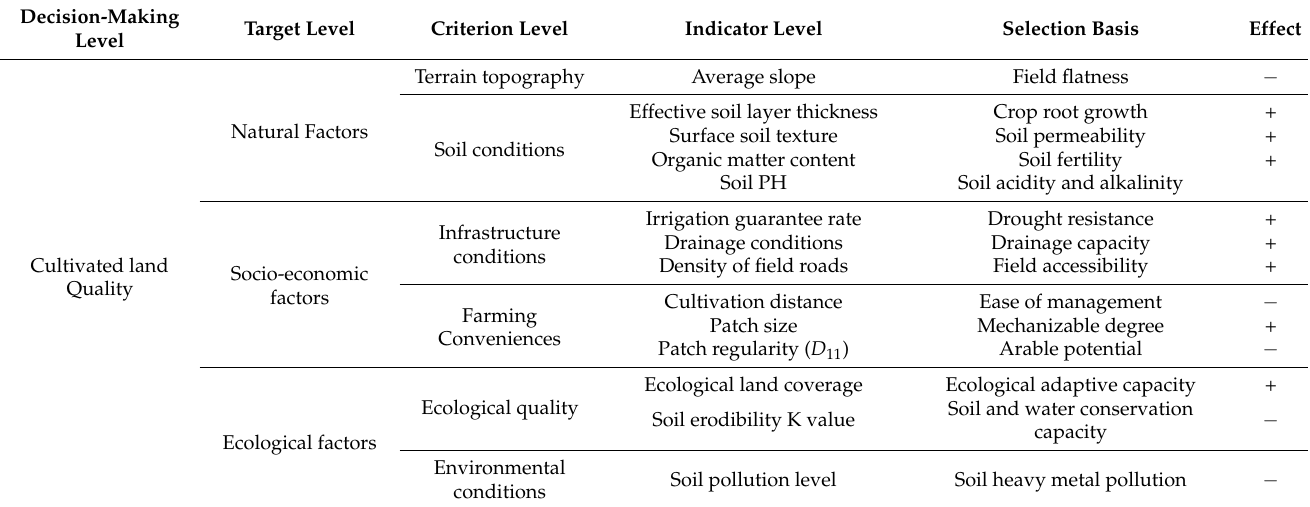
Table 1. Indicator system for evaluating cultivated land quality in Long’an